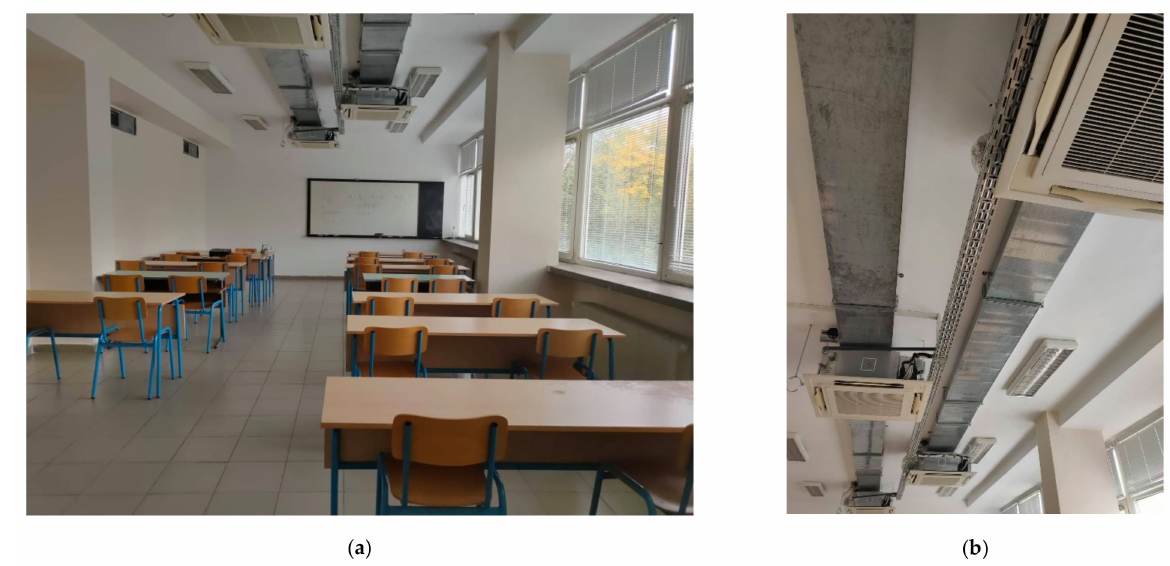
Figure 3. The case study classroom: ( a ) A view from the south wall; ( b ) Part of the HVAC system on the ceiling.